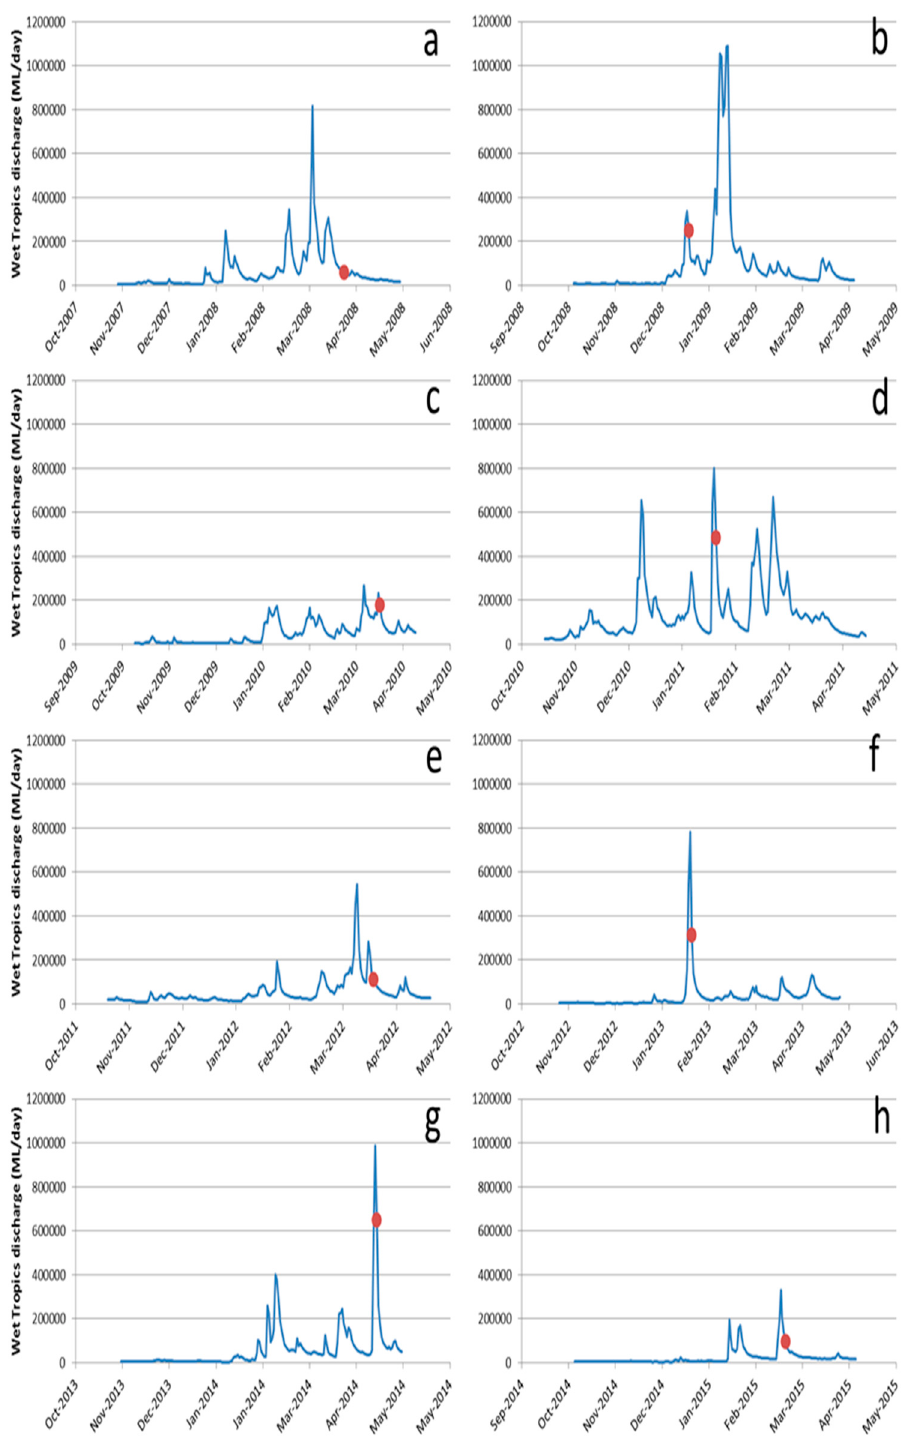
Figure 2. Total daily wet season discharge (November to April, inclusive, ML/day) for the Wet Tropics rivers for the wet seasons of 2007–2008 ( a ), 2008–2009 (b), 2009–2010 ( c ), 2010–2011 ( d ), 2011–2012 ( e ), 2012–2013 ( f ), 2013–2014 ( g ), 2014–2015 ( h ). Red dots in parts ( d ), ( f ), and ( h ) stand for the day on which the satellite images shown in Figure 3 were taken and are within the CoTS spawning period.